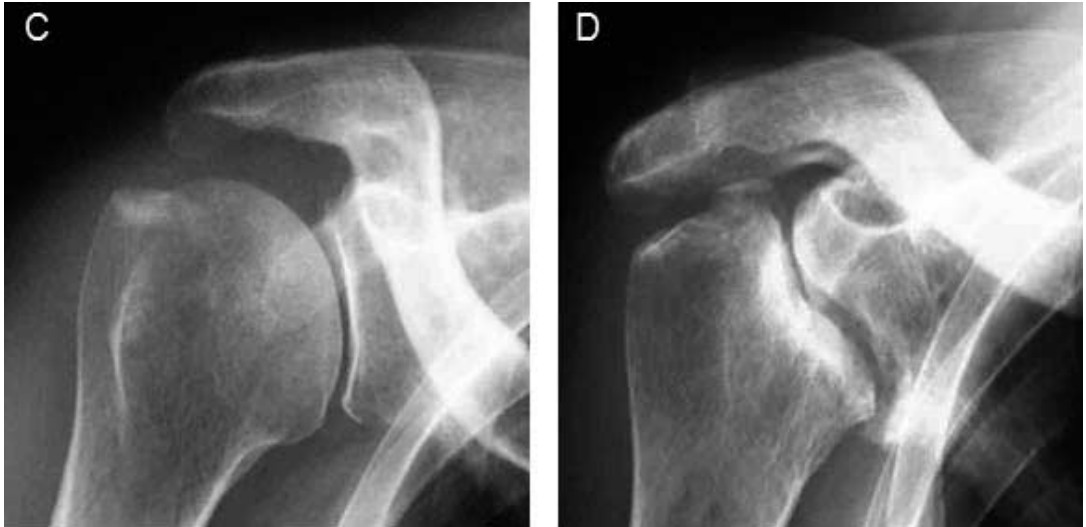
illustrate rapid de- struction of the right shoulder, presumably due to apatite-in- duced inflammation.